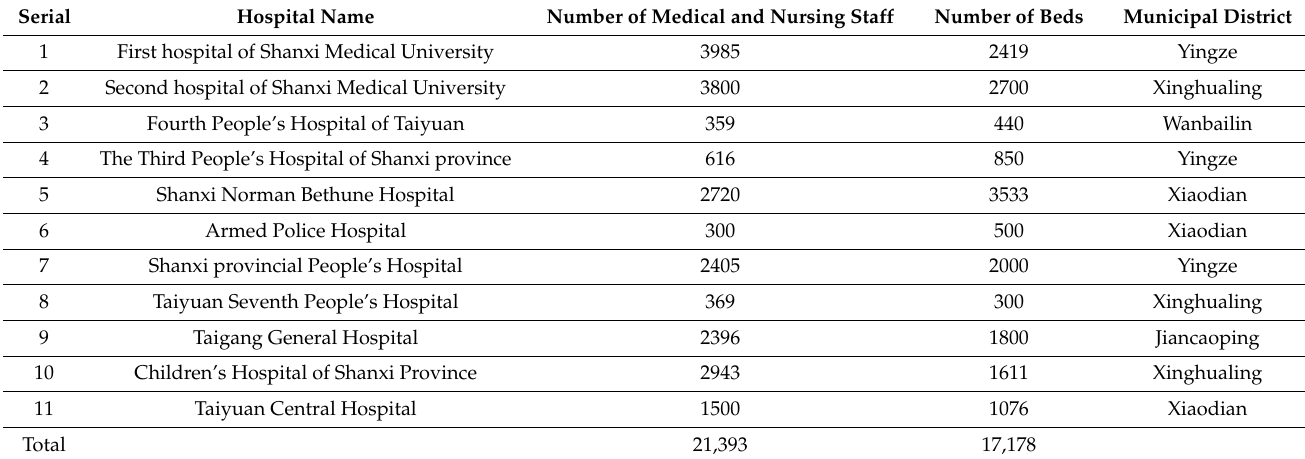
Table 2. Taiyuan tertiary care hospital and